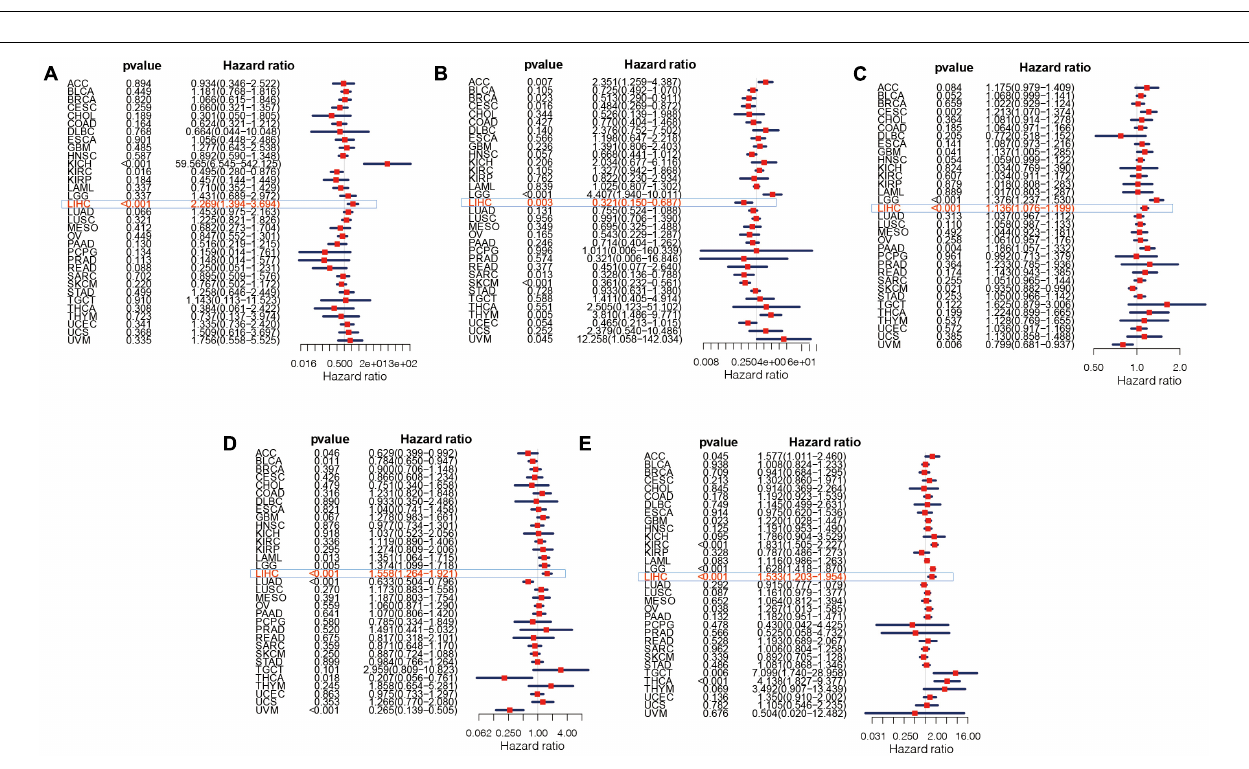
FIGURE 12 | Survival curve of five genes in pan-cancer. (A) ATG10, (B) IL18RAP, (C) SPP1, (D) PRKCD, and (E) SLC11A1.